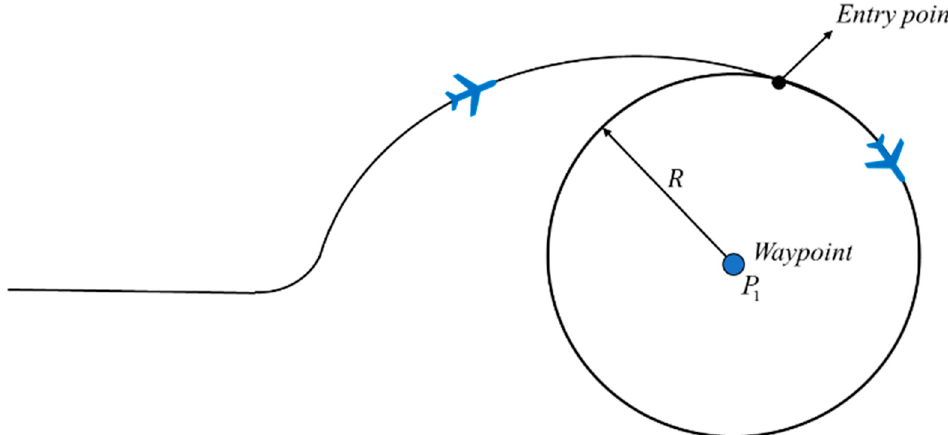
Figure 7. Hovering mode in actual flight.